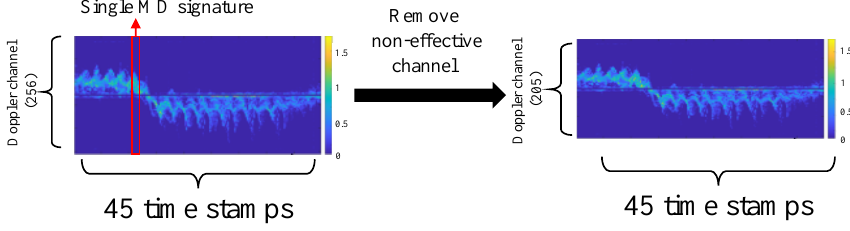
Figure 2. Illustration of Generating Micro-Doppler signature for Dual-Scale Doppler Attention.